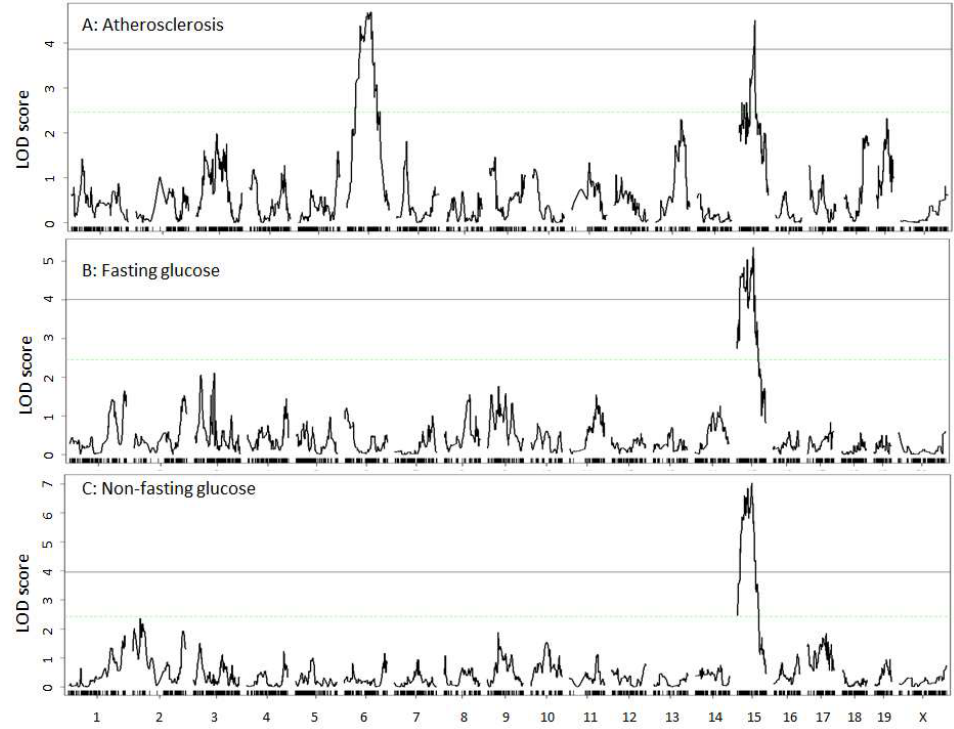
Figure 3. Genome-wide scans to search for loci influencing carotid atherosclerosis ( A ), fasting plasma glucose ( B ), and non-fasting glucose levels ( C ). Chromosomes 1 through X are represented on the X axis. Each short vertical bar on the X axis represents a SNP marker. The Y axis represents the LOD score. The two horizontal lines represent the genome-wide thresholds for significant (black) and suggestive linkage (green).